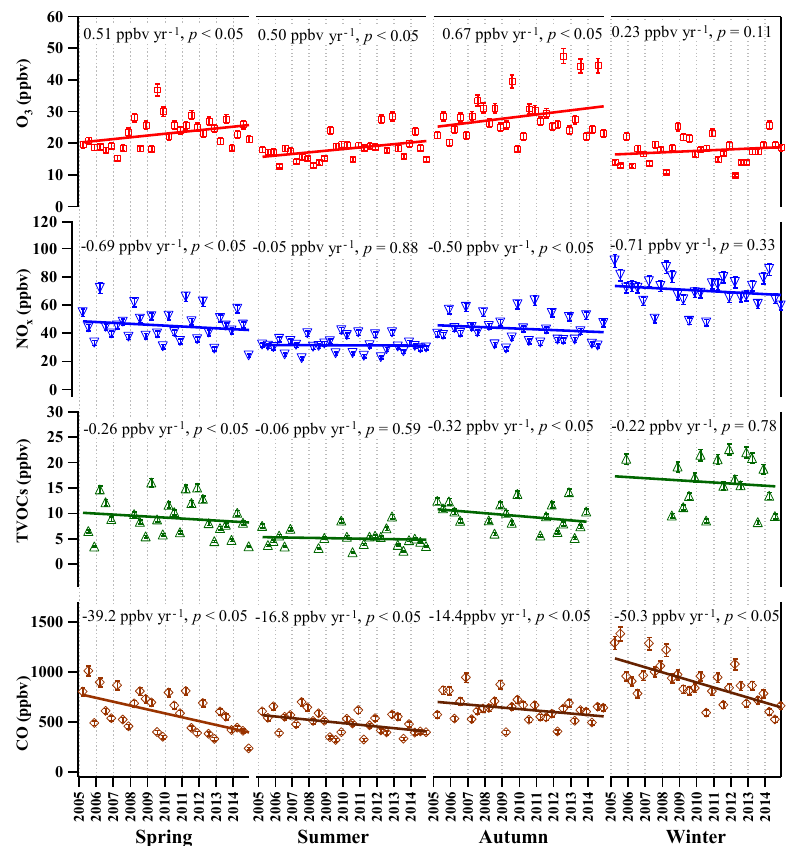
Figure 3. Variations of O 3 and its precursors in four seasons at TC during 2005–2014. Each data point in the figure is obtained by averaging hourly values into a monthly value. Error bars represent 95% confidence intervals of the averages. In the sub-plot for O 3 trend in autumn, the three extremely high values are not considered as outliers as each of them represents 1 month of data with relatively small uncertainty (see Fig.